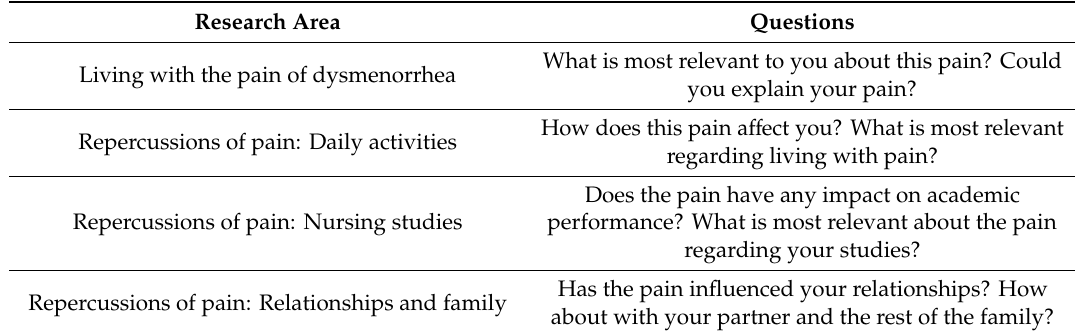
Table 2. Semi-structured focus group question